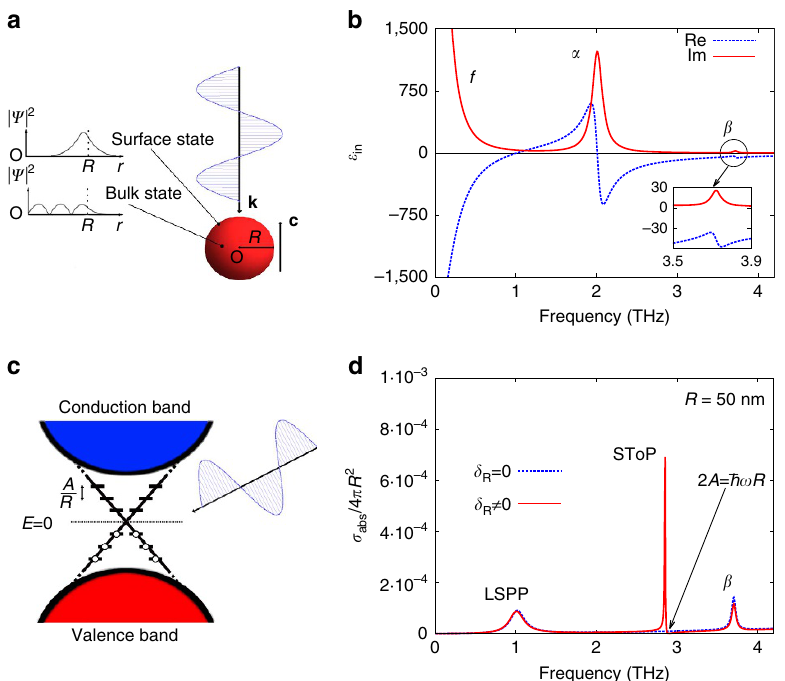
Figure 1 | TINP interacting with light ( a ) The system studied: a spherical Bi 2 Se 3 nanoparticle of radius R located at the origin is subject to an EM wave propagating along its c axis— k c k . The collective response of the bulk states is described using the dielectric function E in , whereas the surface states are treated quantum mechanically. ( b ) The dielectric function E in of Bi 2 Se 3 comprises two phonons at 2.0 ( a ) and 3.72THz ( b ), as well as a contribution from bulk free charge carriers ( f ) at low frequencies 25 . ( c ) In the nanoparticle, the surface Dirac cone consists of discrete levels symmetrically placed with respect to the Dirac point ( E ¼ 0) 17 . They have constant energy spacing A / R where A ¼ 3.0eV (cid:3) Å. An electron in a surface state couples to other states under the influence of light producing a time-dependent surface charge density. ( d ) The absorption cross-section of a bare nanoparticle ( d R ¼ 0, blue dashed line) is dictated by the dielectric function of the material. It is modified when electrons occupy delocalized topological surface states ( d R a 0, red solid line). The resultant spectrum contains an additional mode (SToP) and a zero in absorption (marked with an arrow).